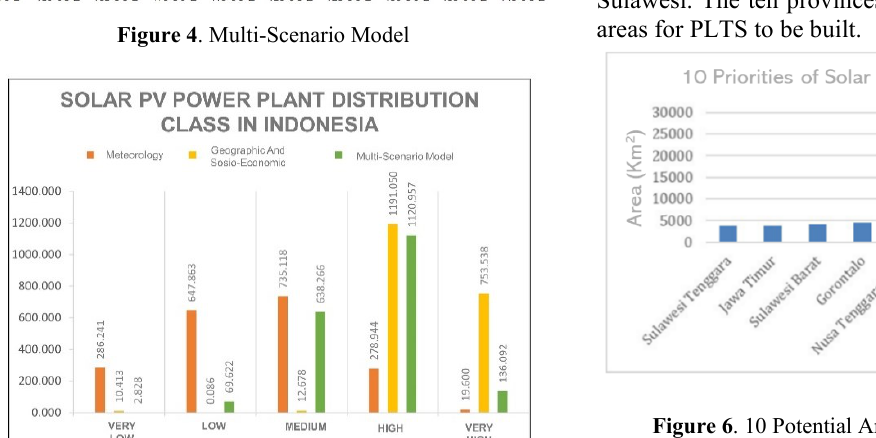
Figure 6 . 10 Potential Areas for PLTS Construction